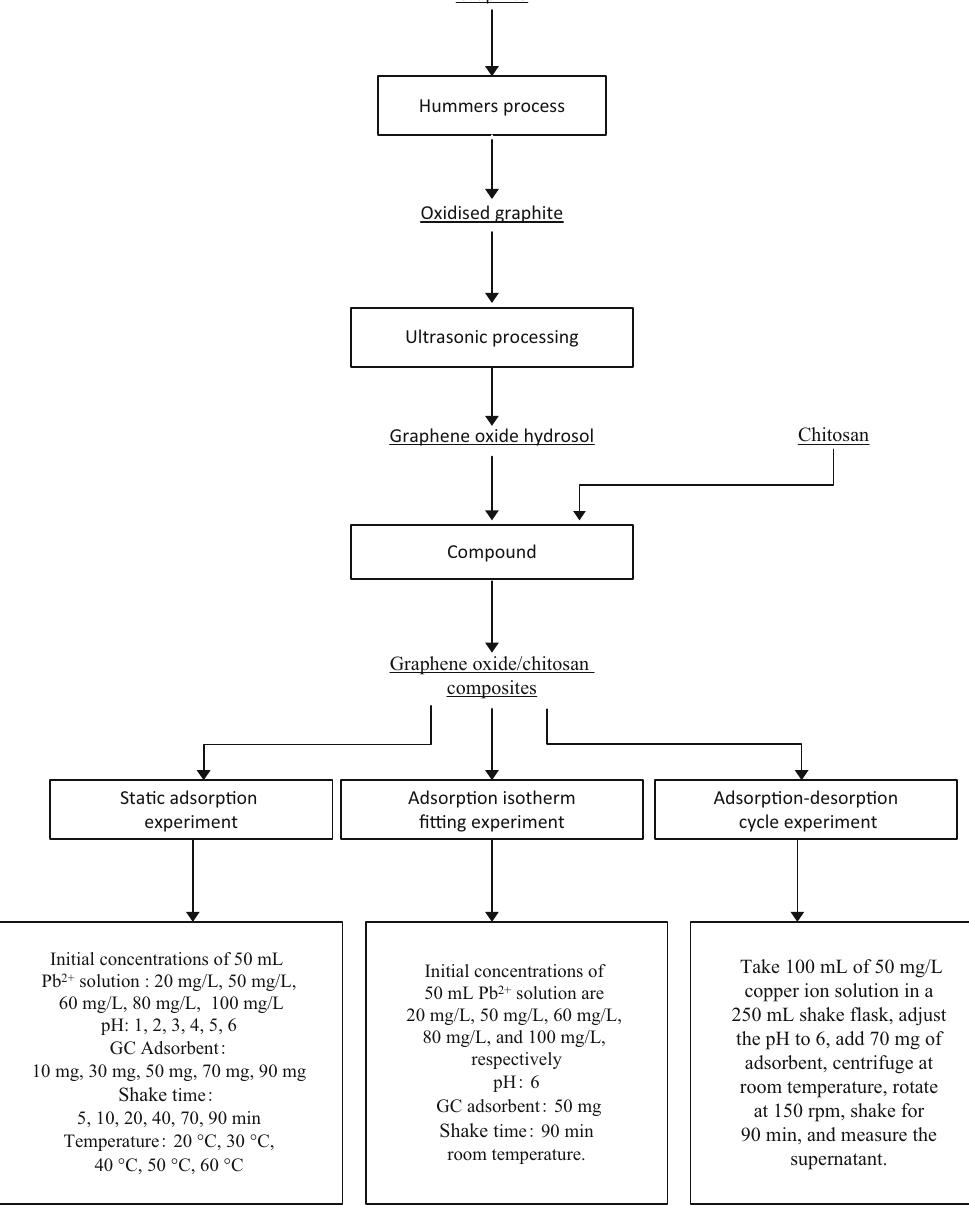
Scheme 1: Experimental ideas and experimental conditions of this